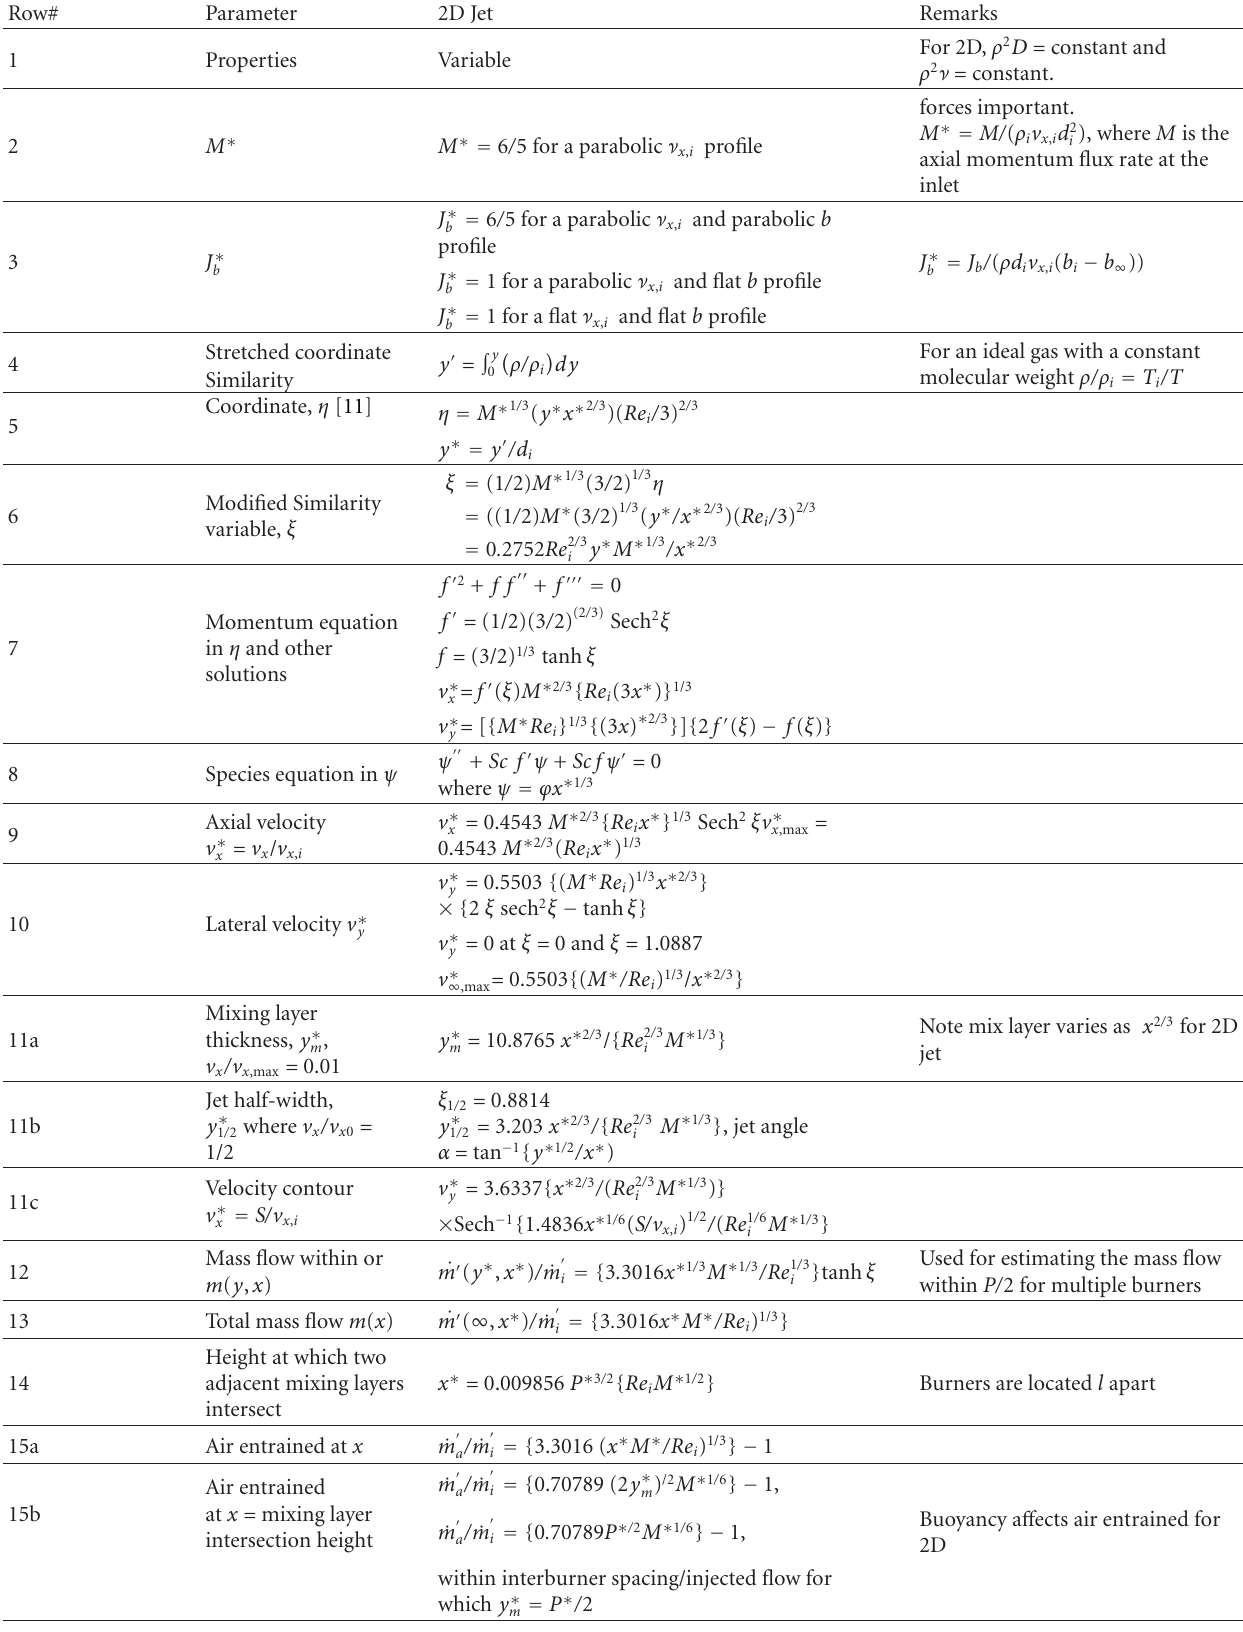
Table 1: Summary of single, laminar jet results for 2D planar jet under non-buoyant conditions.